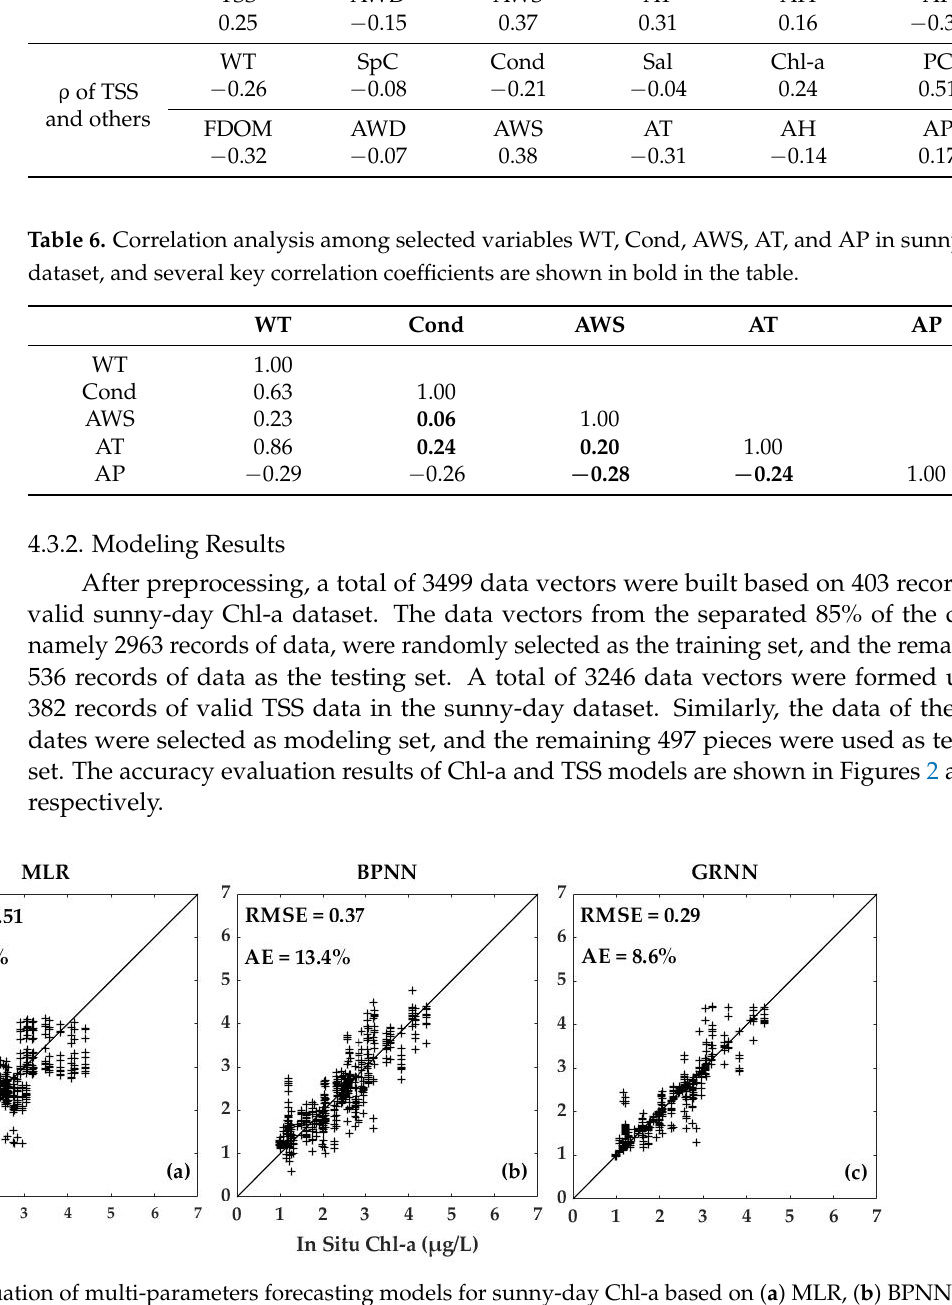
Figure 3. Accuracy evaluation of multi-parameters forecasting models for sunny-day TSS based on ( a ) MLR, ( b ) BPNN, and ( c ) GRNN. From Figure 2, we can see the testing RMSE for MLR, BPNN, and GRNN-based Chl- a prediction models by using sunny-day Chl-a data are 0.51, 0.37 and 0.29, while the RMSE listed in Table 3 for three prediction models constructed using all-valid Chl-a data are 0.63, 0.54, and 0.41. The testing AEs for three Chl-a prediction models by using sunny-day data are 17.8%, 13.4%, and 8.6%, while the AEs listed in Table 3 for three prediction models constructed using all-valid Chl-a data are 18.9%, 15.6%, and 11.4%. So we can say that the performance of the MLR, BPNN, and GRNN-based models built with the sunny-day dataset are much better than those models base on the all-valid dataset. The same conclusion is satisfied with TSS prediction models. GRNN-based forecasting models for Chl-a and TSS have the highest accuracy no matter what kinds of data are used to construct them. From Figures 2 and 3, it can be seen that the in situ data and prediction data by using a GRNN-based model have more tight positive correlation than other models. RMSE of GRNN-based prediction models of Chl- a and TSS are 0.29 and 4.85, which is significantly lower than other models. In addition, the AEs of GRNN-based prediction models of Chl-a and TSS are only 8.6% and 8.2%; both are less than 10%, which can effectively predict the changes of Chl-a and TSS. In addition, we performed statistical analysis on the residuals of the GRNN-based model built in the sunny-day dataset. The result shows that the mean values of the residuals of the GRNN-based Chl-a and TSS models were − 0.0016 and − 0.0131, respectively, both of which are close to zero, and the residuals of the two models basically satisfied the normal distribution, which proves that